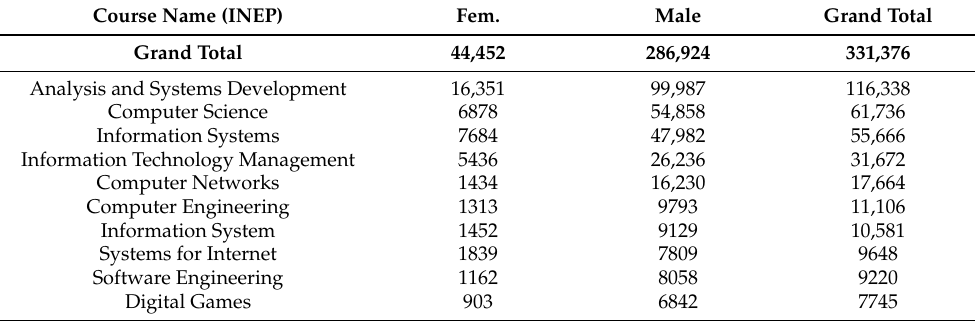
Table 2. Computing and Information and Communication Technologies Area, according to the International Standardized Classification of Education (CINE), from the Higher Education Census. Course Name (INEP) Fem.